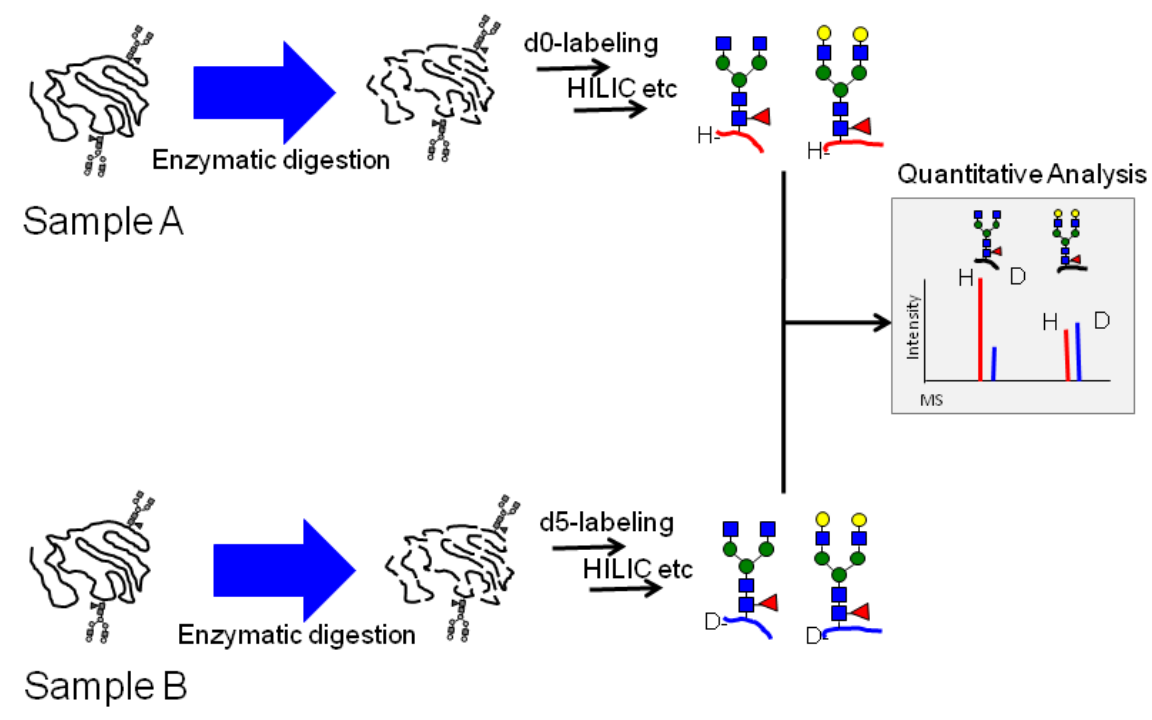
Figure 1. Strategy for quantitative and comparative analysis based on stable isotope labeling using MALDI